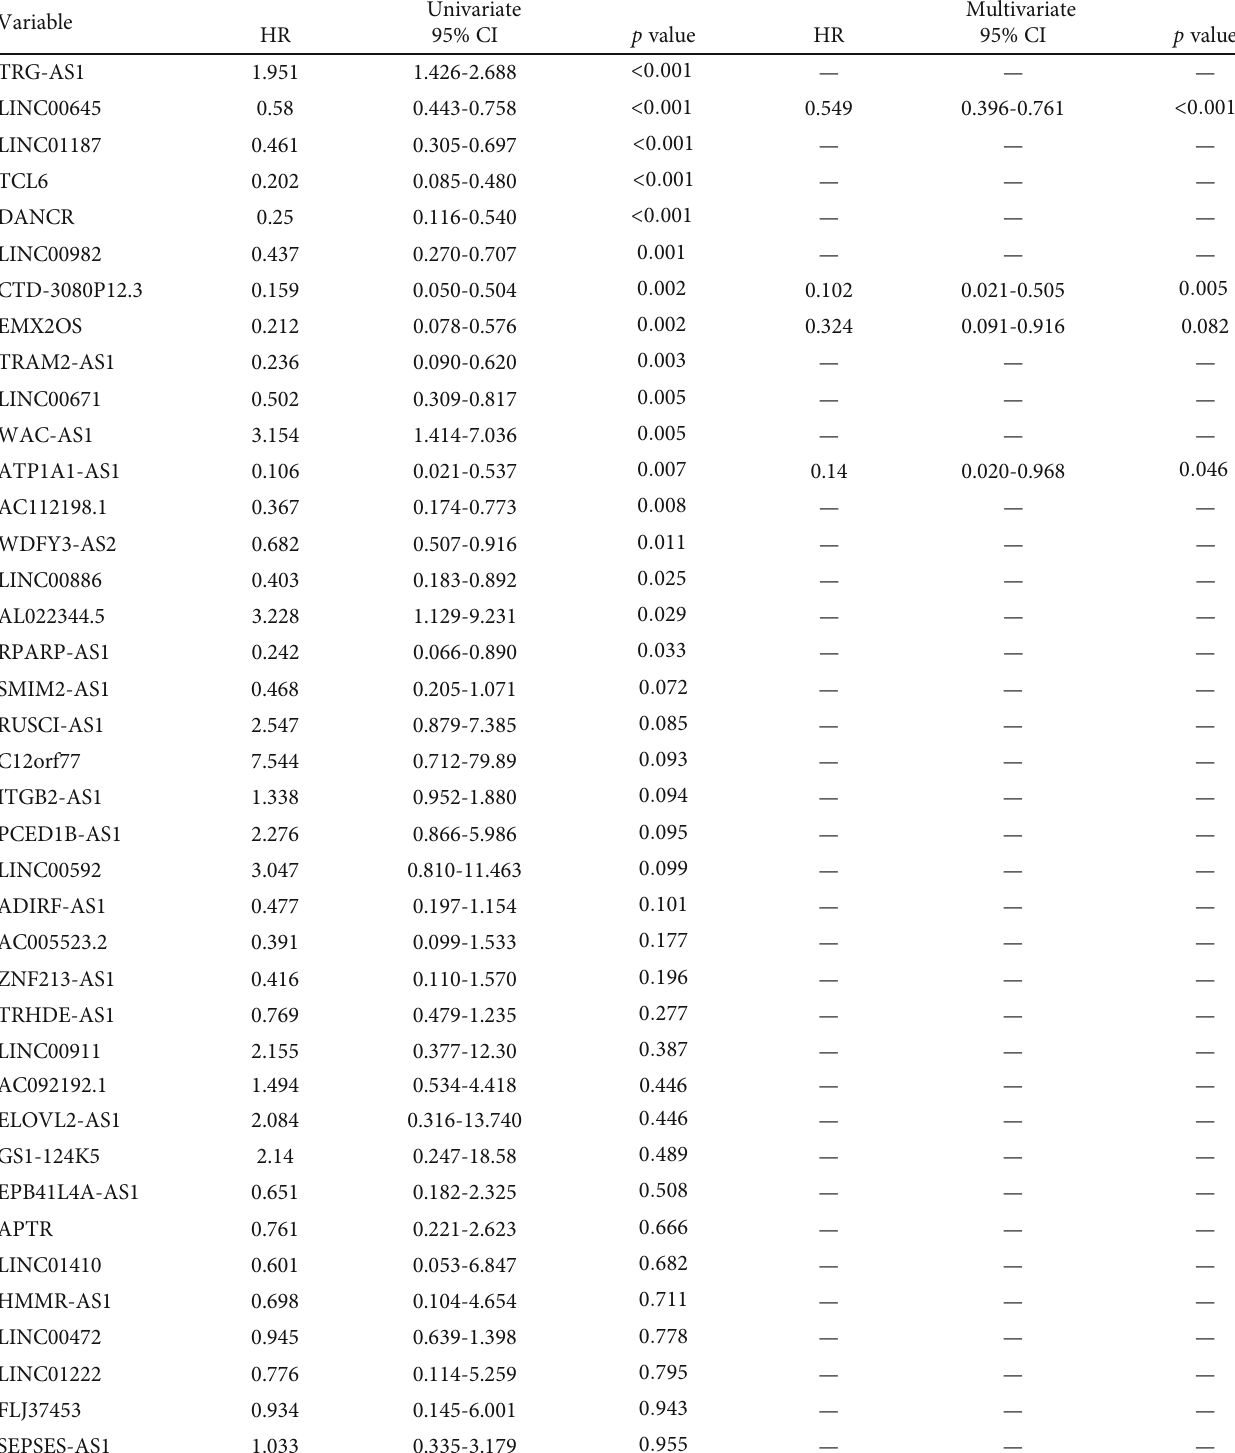
Table 2: Univariate and multivariate Cox regression of 39 DElncRNAs in the training set of GSE21374. Univariate Variable